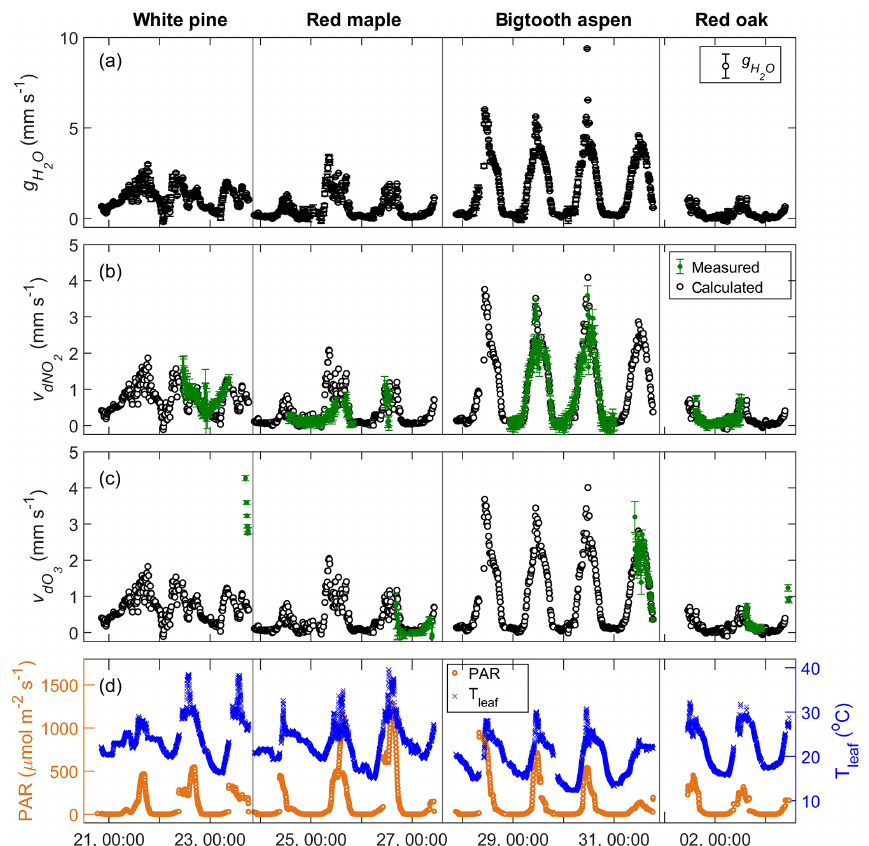
Figure 5. Time series plots of (a) the measured stomatal conductance of water; (b) the measured foliar deposition velocity (green symbols) and the calculated stomatal uptake rate (black symbols) of NO 2 ; (c) the measured foliar deposition velocity (green symbols) and the calculated stomatal uptake rate (black symbols) of O 3 ; and (d) the corresponding PAR and leaf temperature during the experiments from 21 July to 3 August